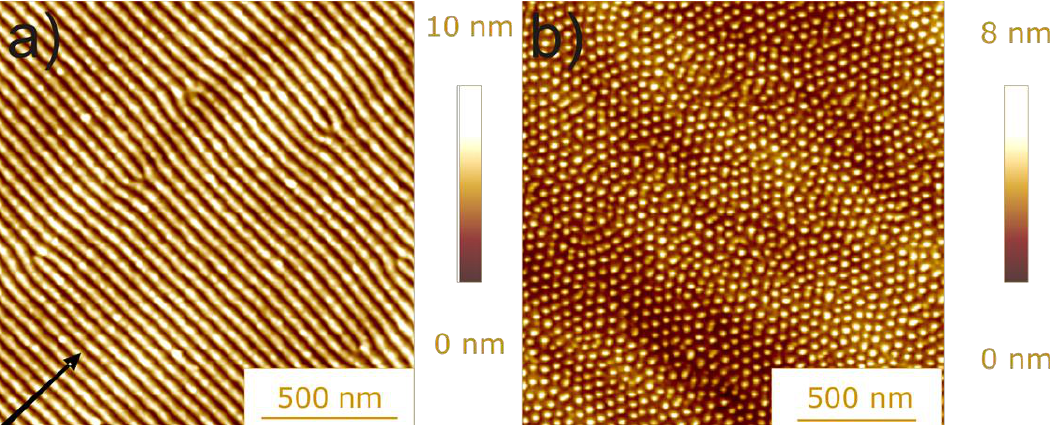
Figure 20 . Surface topography after ion bombardment: (a) Si surface, 1200 eV Ar + , 15° off-normal; the arrow indicates the projected ion beam direction. (b) Ge surface, 2000 eV Xe + , 20° off-normal